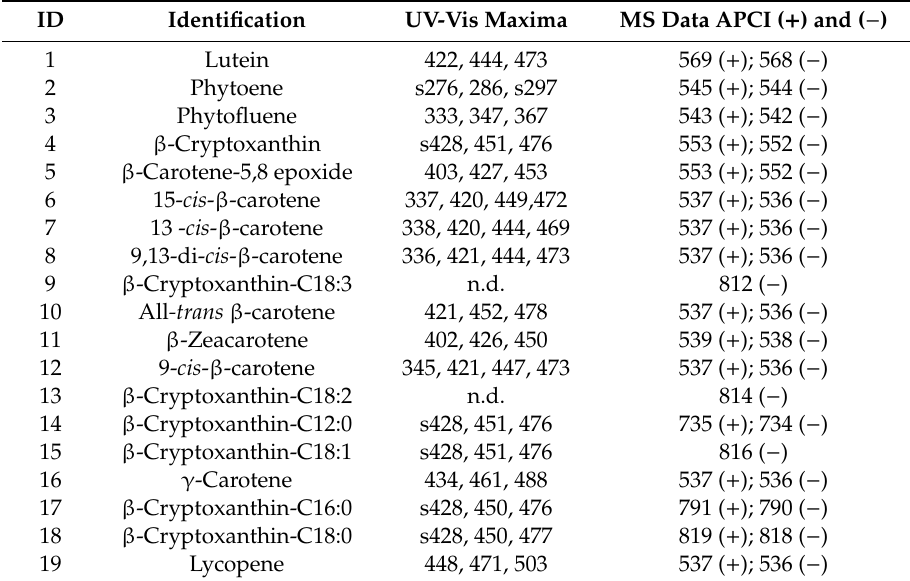
Table 1. UV-Vis and MS APCI ( + ) and APCI ( − ) information and identification of the carotenoids in the analyzed apricots